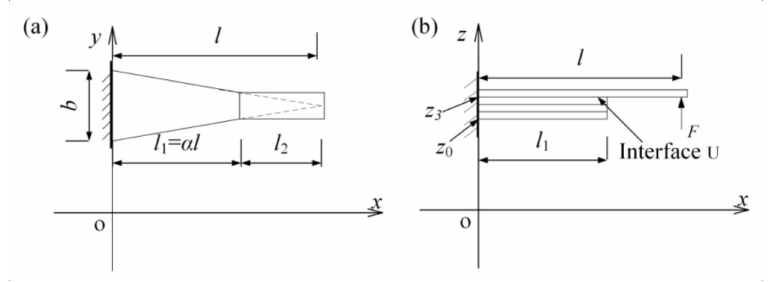
Figure 4. Geometry of the tactile sensor in ( a ) top view and ( b ) side